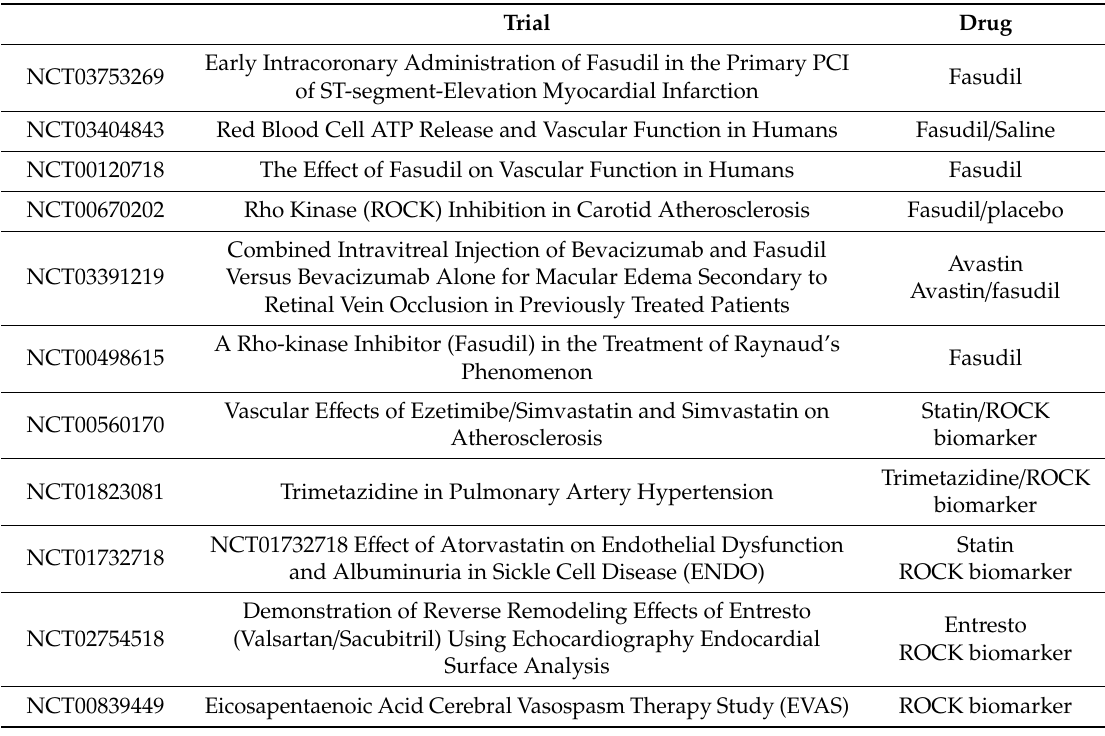
Table 1. Clinical Trials Targeting RhoGTPase in Vascular Diseases.